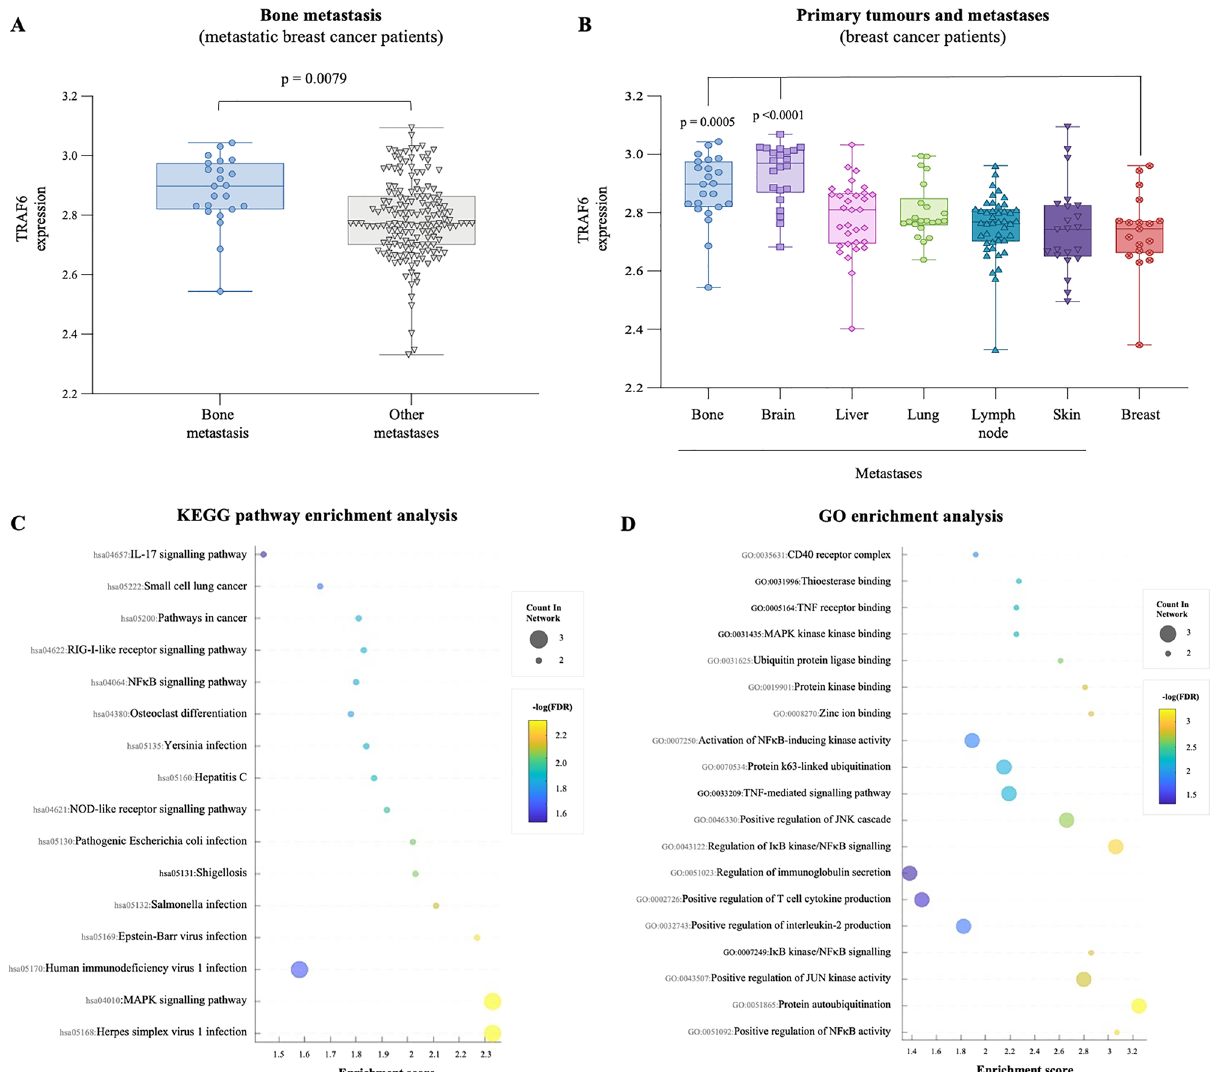
Figure 3. Differential expression and enrichment analysis of TRAFs. ( A ) TRAF6 expression in bone (n = 23) and other tumours (n = 161) from breast cancer patients. ( B ) TRAF6 expression in primary breast (n = 19), bone (n = 23), brain (n = 22), liver (n = 32), lung (n = 22), lymph nodes (n = 44), and skin (n = 22) tumours from breast cancer patients (The Molecular Taxonomy of Breast Cancer International Consortium (METABRIC) dataset) 64,65 . ( C , D) KEGG pathway ( C ) and GO ( D ) enrichment analyses of TRAF2, 4, 6. The bubble charts ordinates show the path names, abscissa represents enrichment score, size of circles indicates the number of matching, and circle color represents the value of − log10 (FDR). FDR denotes False Discovery Rate. Permission has been obtained from Kanehisa laboratories for using KEGG pathway database (www. kegg. jp/ kegg/ kegg1.